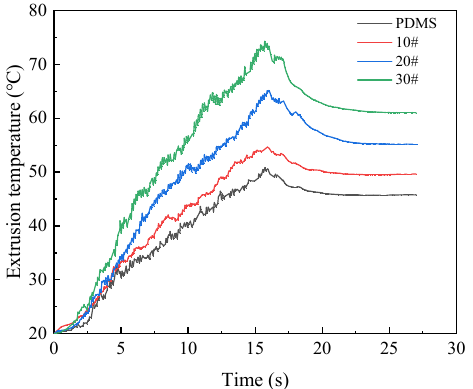
Figure 22. Influence of lubricating medium on